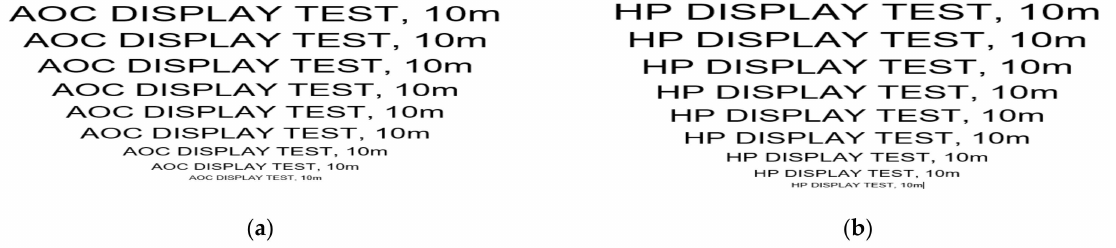
Figure 9. Examples of test images: ( a ) for AOC display; ( b ) for HP display.